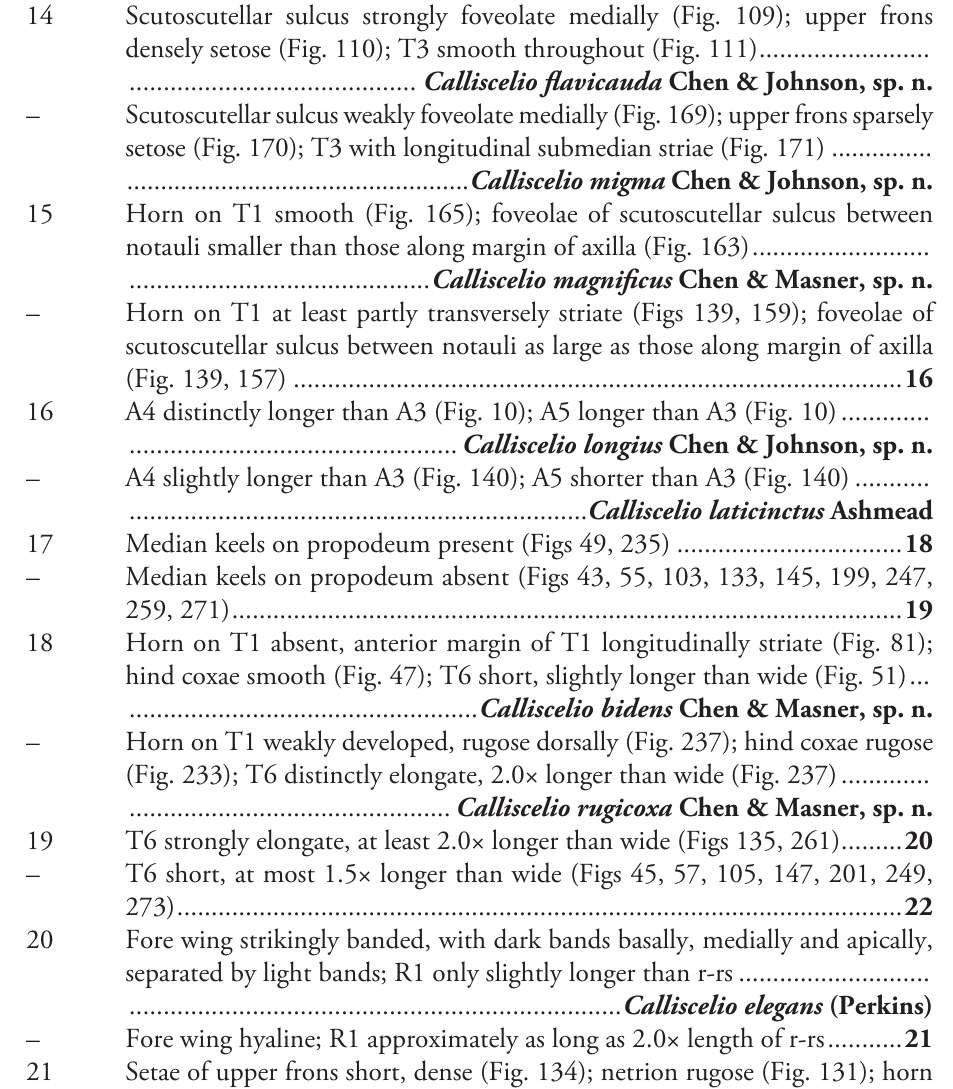
21 Setae of upper frons short, dense (Fig. 134); netrion rugose (Fig. 131); horn